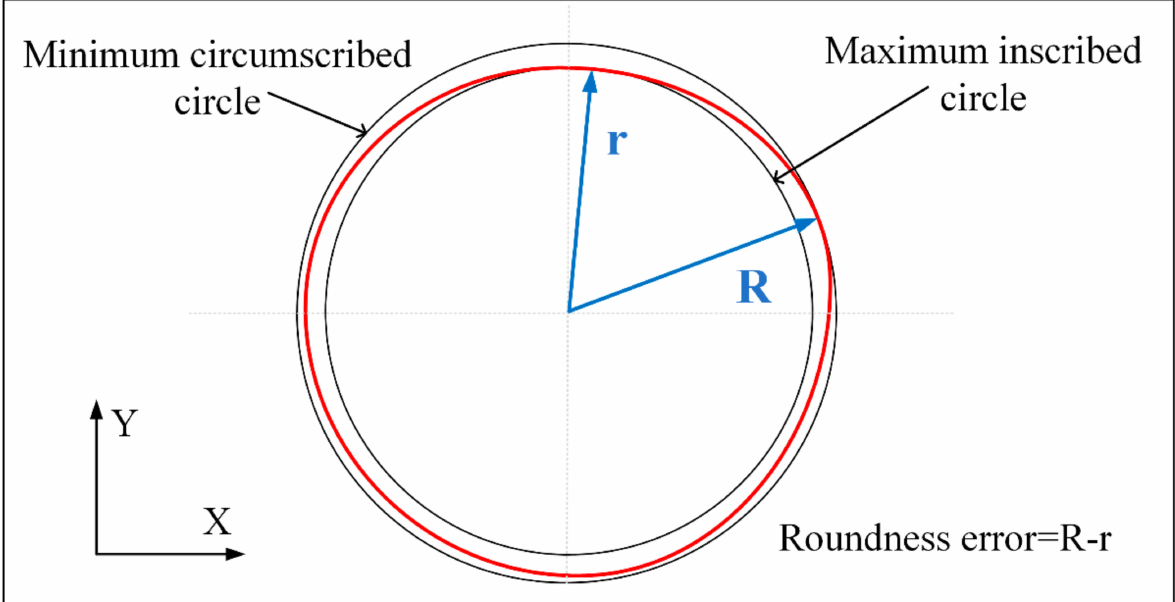
Figure 14. Roundness error calculation